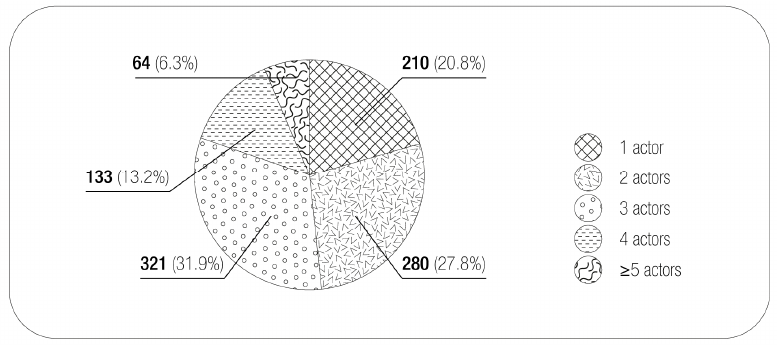
Figure 6. Percentage of the tweets according to the number of actors involved.